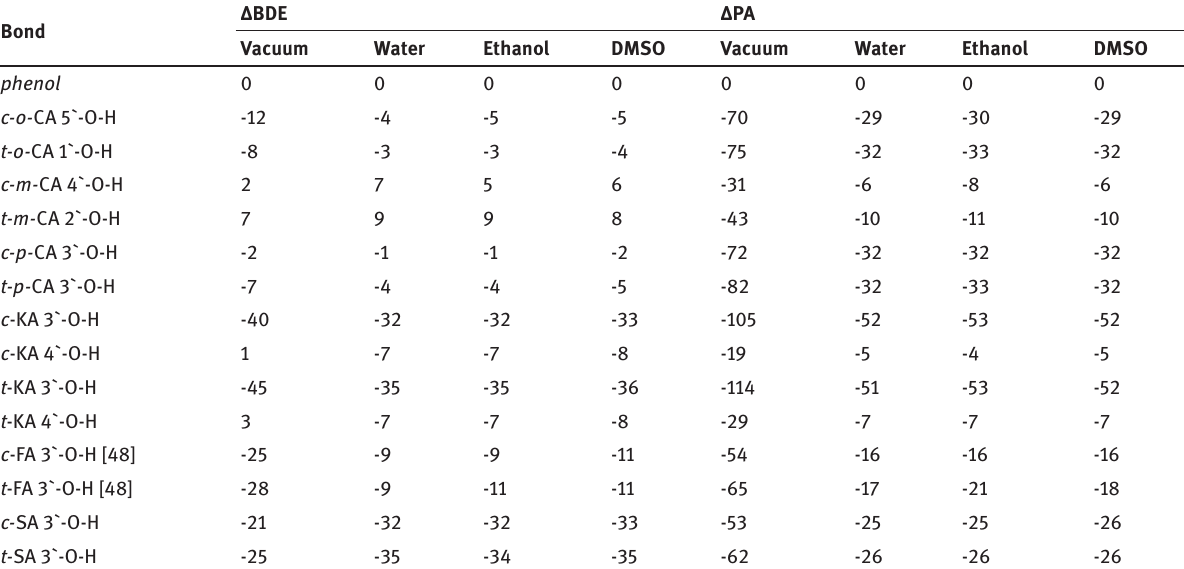
Table 5: ΔBDE and Δ PA [kJ mol -1 ] values calculated with B3LYP/6-311++G(2d,2p) level of theory.